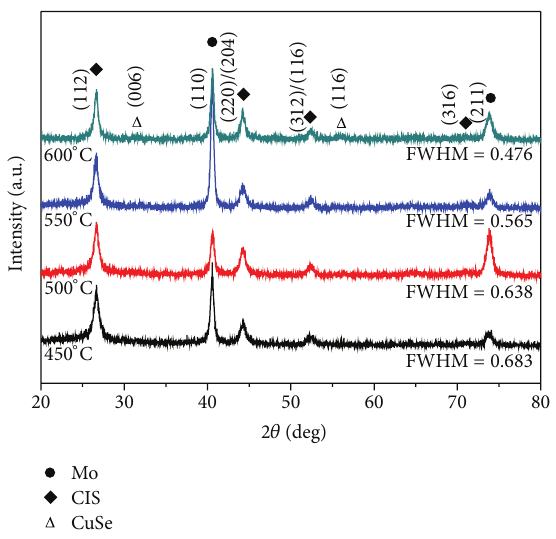
Figure 1: XRD patterns of the CIS absorber layers as a function of selenization temperature, the extra Se content was 0.2